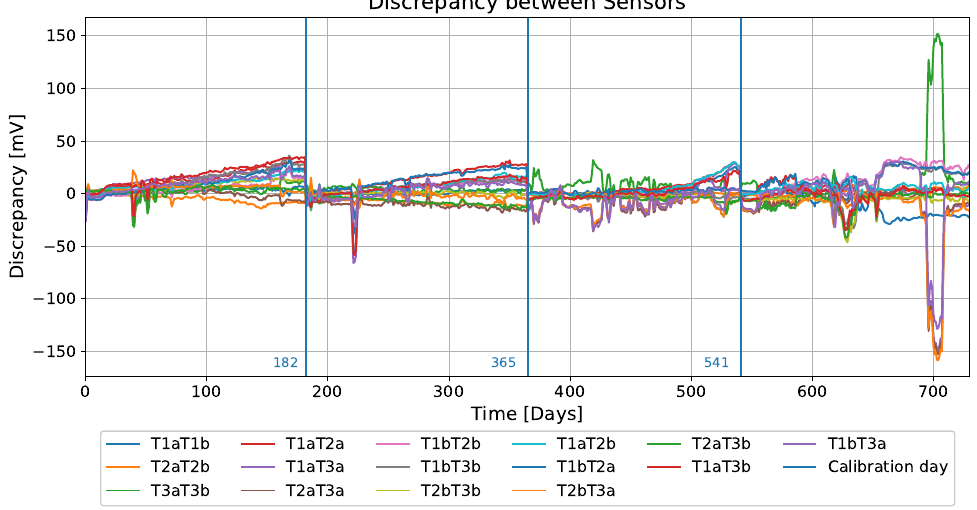
Figure 8. Discrepancy among the sensors’ readings, also showing calibration events on days 183, 365, and